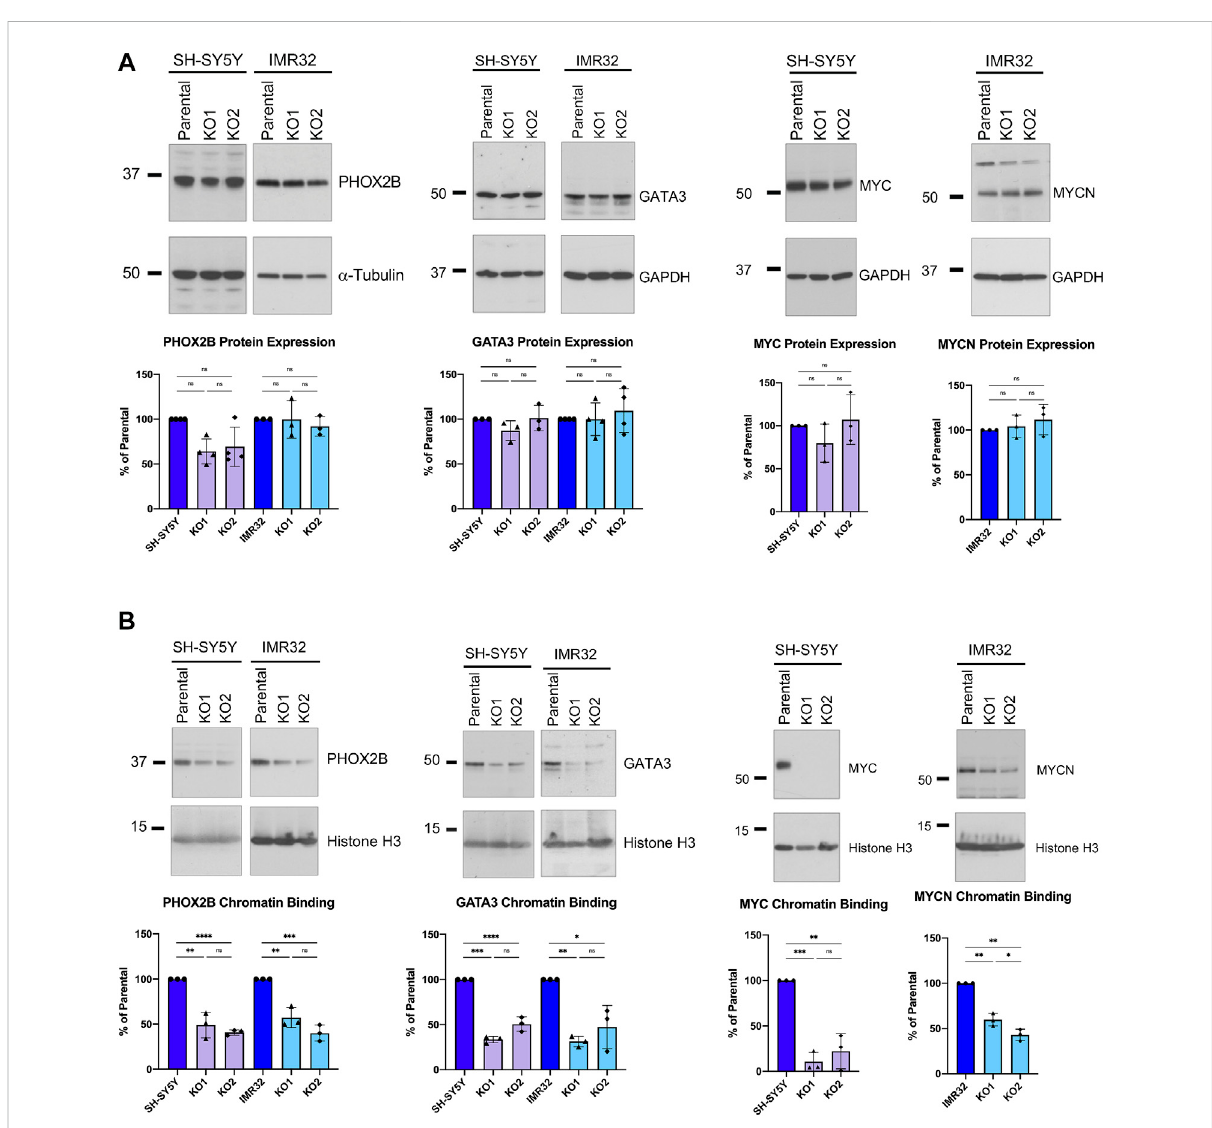
FIGURE 6 ASCL1 KO results in less CRC transcription factor chromatin binding. (A) Western blots showing the overall PHOX2B protein levels (left) and GATA3 levels (centre) and MYC/MYCN levels (right) in parental and ASCL1 KO cells. α -tubulin was used as the loading control for PHOX2B and GAPDHwasusedastheloadingcontrolforGATA3andMYC/MYCN.n=3,graphsshowalldatapointsandthemeanvalue,twotailedunpaired t -test (ns=p= > 0.05). (B) WesternblottoshowPHOX2B(left),GATA3(middle)andMYC/MYCN(right)levelswithinthechromatinfractioninparental and ASCL1 KO cells. Histone H3 was used as the control for the chromatin fraction. n = 3, graphs show all data points and the mean value, two tailed unpaired t -test (ns = p = > 0.05, * = p < 0.05, ** = p < 0.005, *** = p < 0.0005, ****p = <